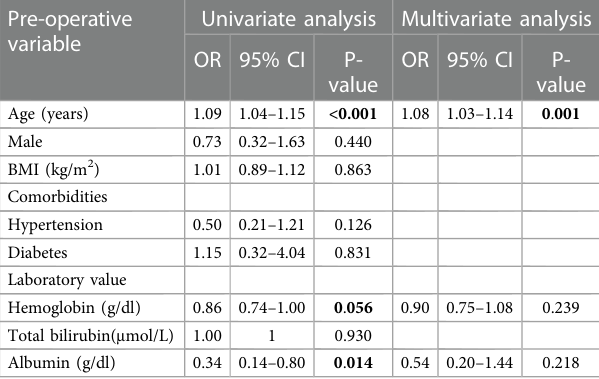
BMI, body mass index. Bold values indicates the P value of potential key